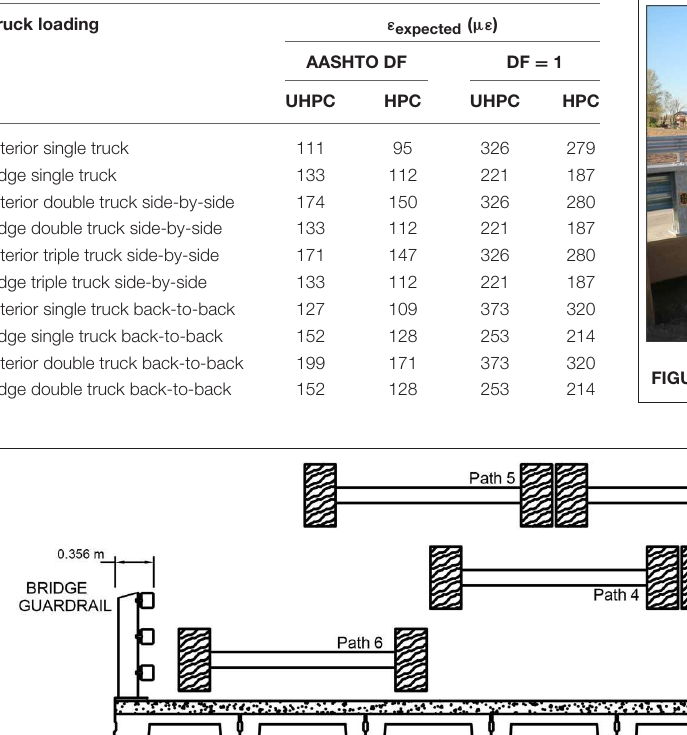
TABLE 3 | Expected strain.